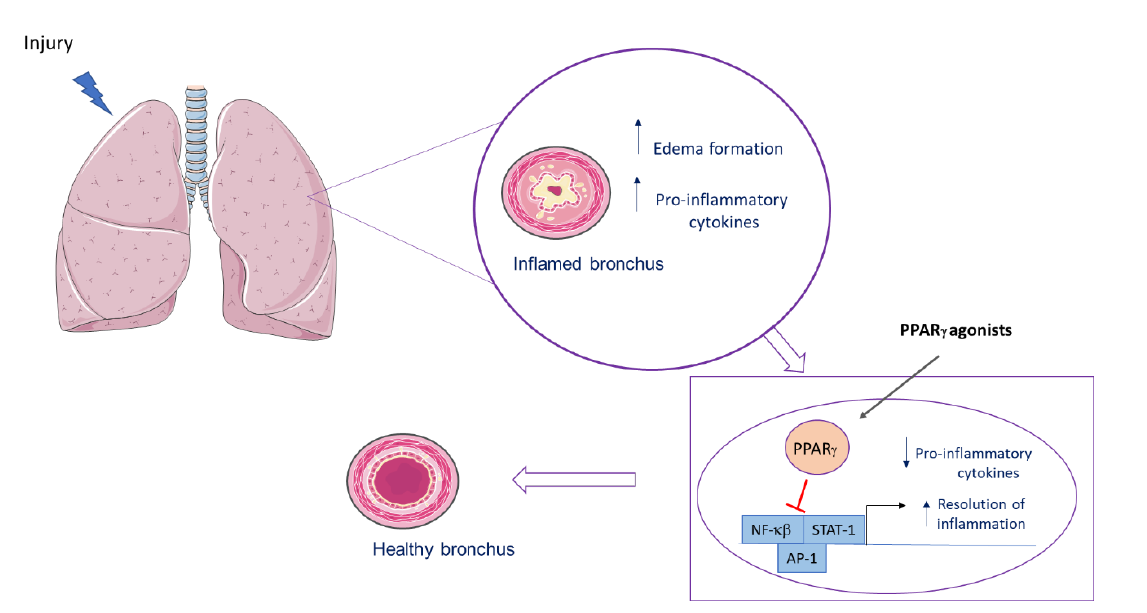
Figure 2. PPARγ role in pulmonary inflammation. Figure 2. PPAR γ role in pulmonary